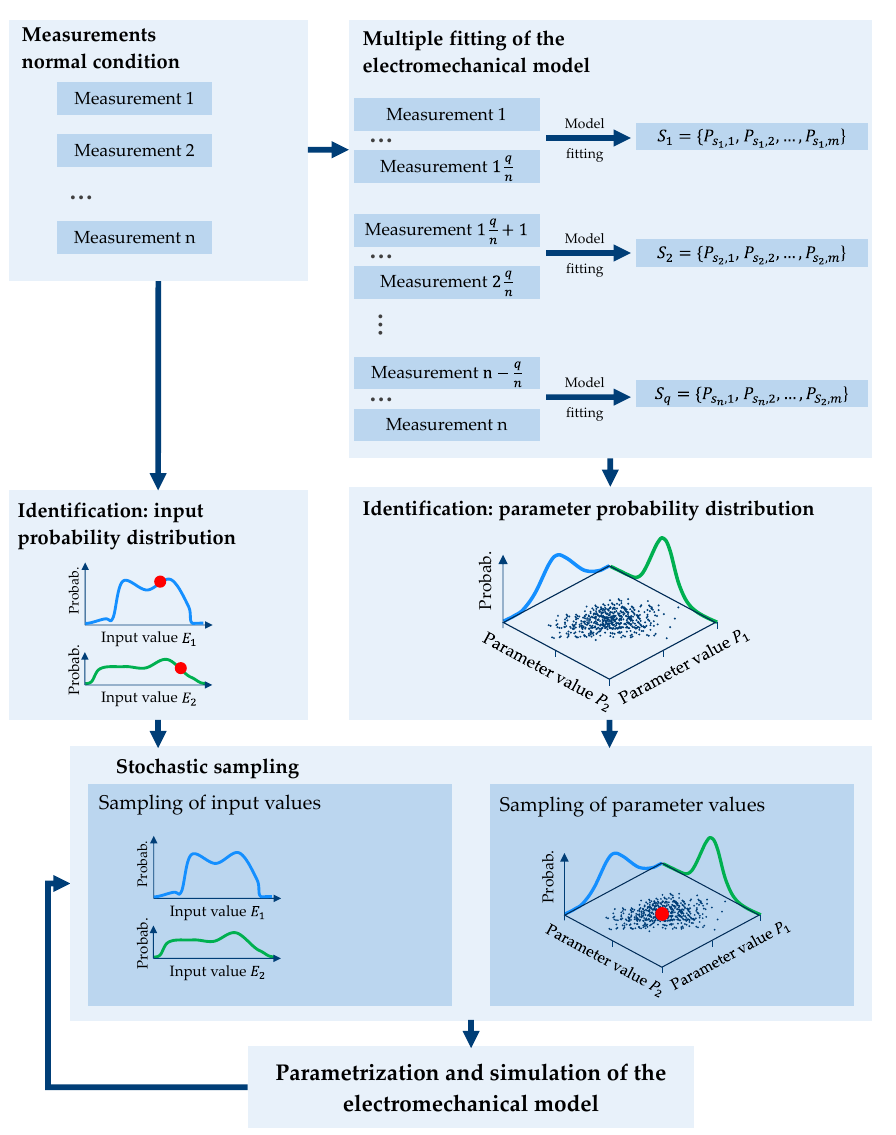
Figure 1. Illustration of generating the database of parameter values and generating synthetic normal-condition data.